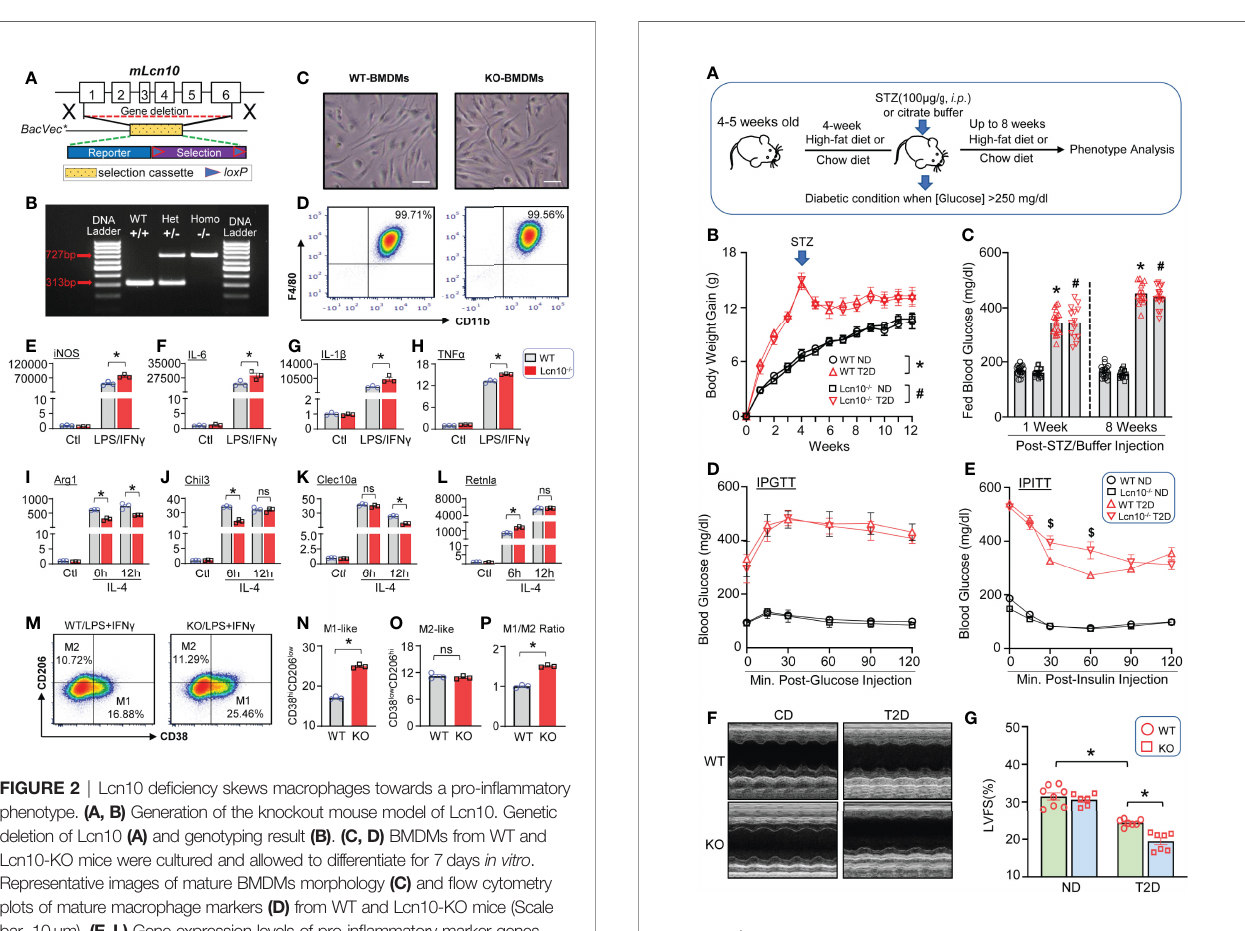
FIGURE 3 | Loss of Lcn10 exacerbates insulin resistance and cardiac dysfunction under diabetic conditions. (A) Schematic illustration of T2D experimental design. (B) Body weight gain (n = 7-8 mice per group) and (C) fed blood glucose were determined in ND and T2D mice (n = 14-18 mice per group) ( B, C , * P < 0.05, when comparing WT-ND to WT-T2D; # P < 0.05 when comparing KO-ND to KO-T2D). (D, E) Blood glucose level during IPGTT (D) (n = 6-7 mice per group) and IPITT (E) at 8 weeks after STZ injection ( $ P < 0.05 when comparing WT-T2D to KO-T2D, n=6-8 mice per group). (F, G) Cardiac function was evaluated by echocardiography at 8 weeks after STZ injection (* P < 0.05, n = 6-8 mice per group). All data are presented as mean ± SEM and analyzed by two-way ANOVA. STZ, streptozotocin; LVFS, left ventricular fractional shortening; IPGTT, intraperitoneal glucose tolerance test; IPITT, intraperitoneal insulin tolerance test.